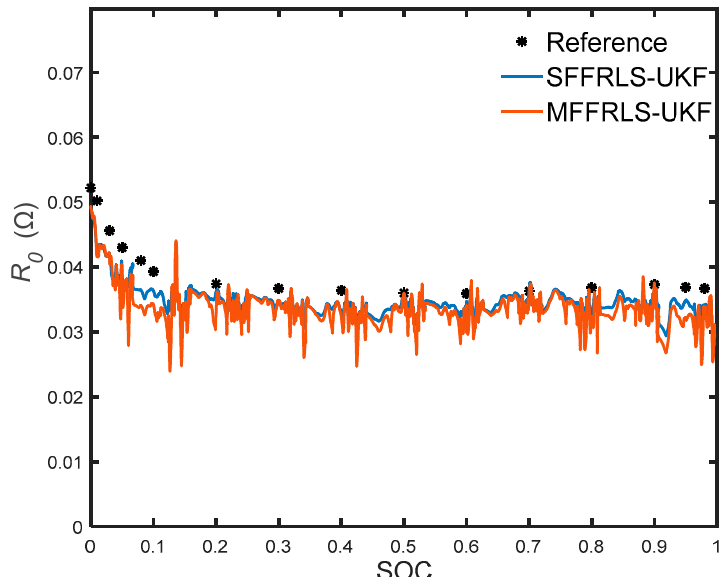
Figure 6. Identification result of R 0 by SFFRLS-UKF and MFFRLS-UKF.